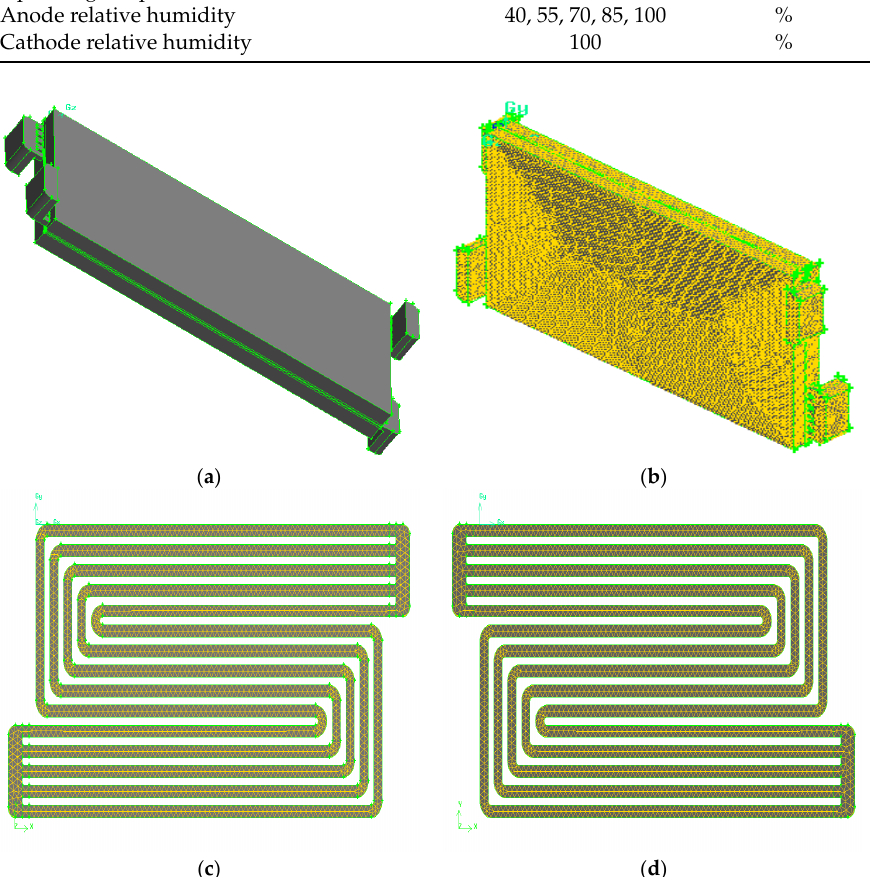
Figure 2. The proton exchange membrane fuel cell (PEMFC) geometry and mesh. ( a ) PEMFC geometry; ( b ) PEMFC mesh generation; ( c ) The anode flow channels; ( d ) The cathode flow channels mesh. Table 1. Parameters in the anode relative humidity (ARH) model.